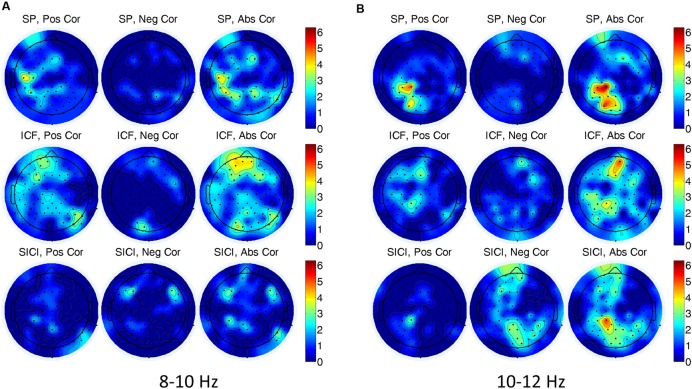
Number of subjects having significant (P < 0.05) correlations between electroencephalogram (EEG) alpha power and the amplitude of MEPs for (A) 8–10 Hz, and (B) 10–12 Hz frequency bands in three TMS conditions. In (A,B) left, center, and right correspond to the number of the subjects for positive, negative, and absolute-value correlations, respectively. A color designates the number of subjects showing a significant correlation.